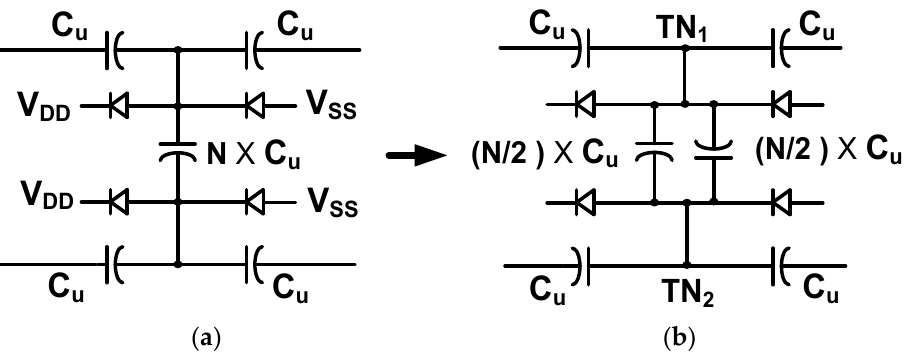
Figure 5. Schematic of the feedback T-network capacitor. ( a ) Conventional configuration; ( b ) modified configuration for symmetrical parasitic behavior.